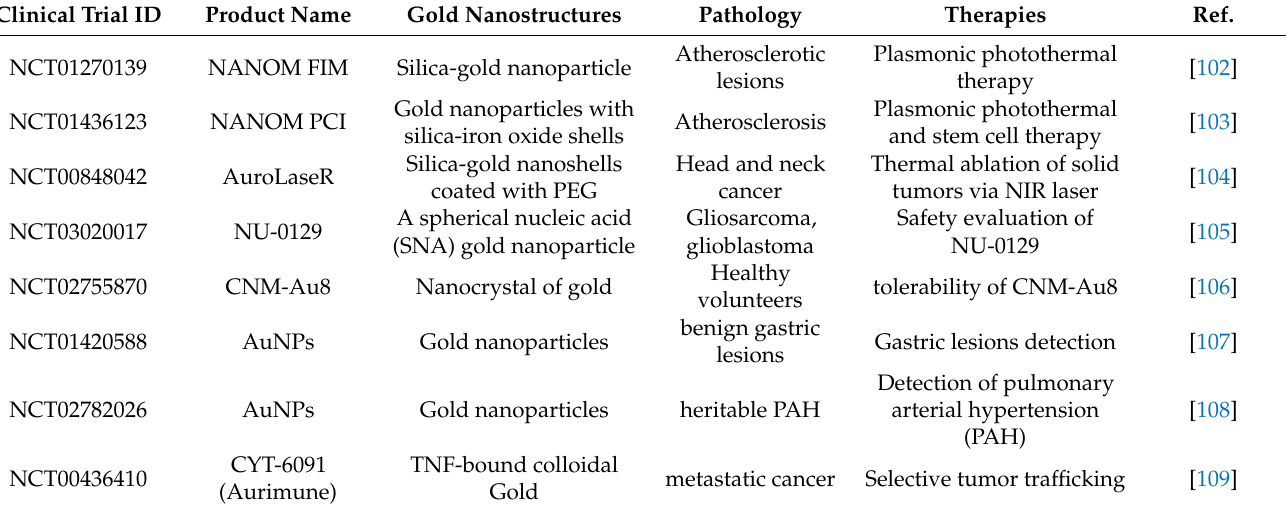
Table 3. Clinical trials on GNPs for phototherapies and other cancer-related health